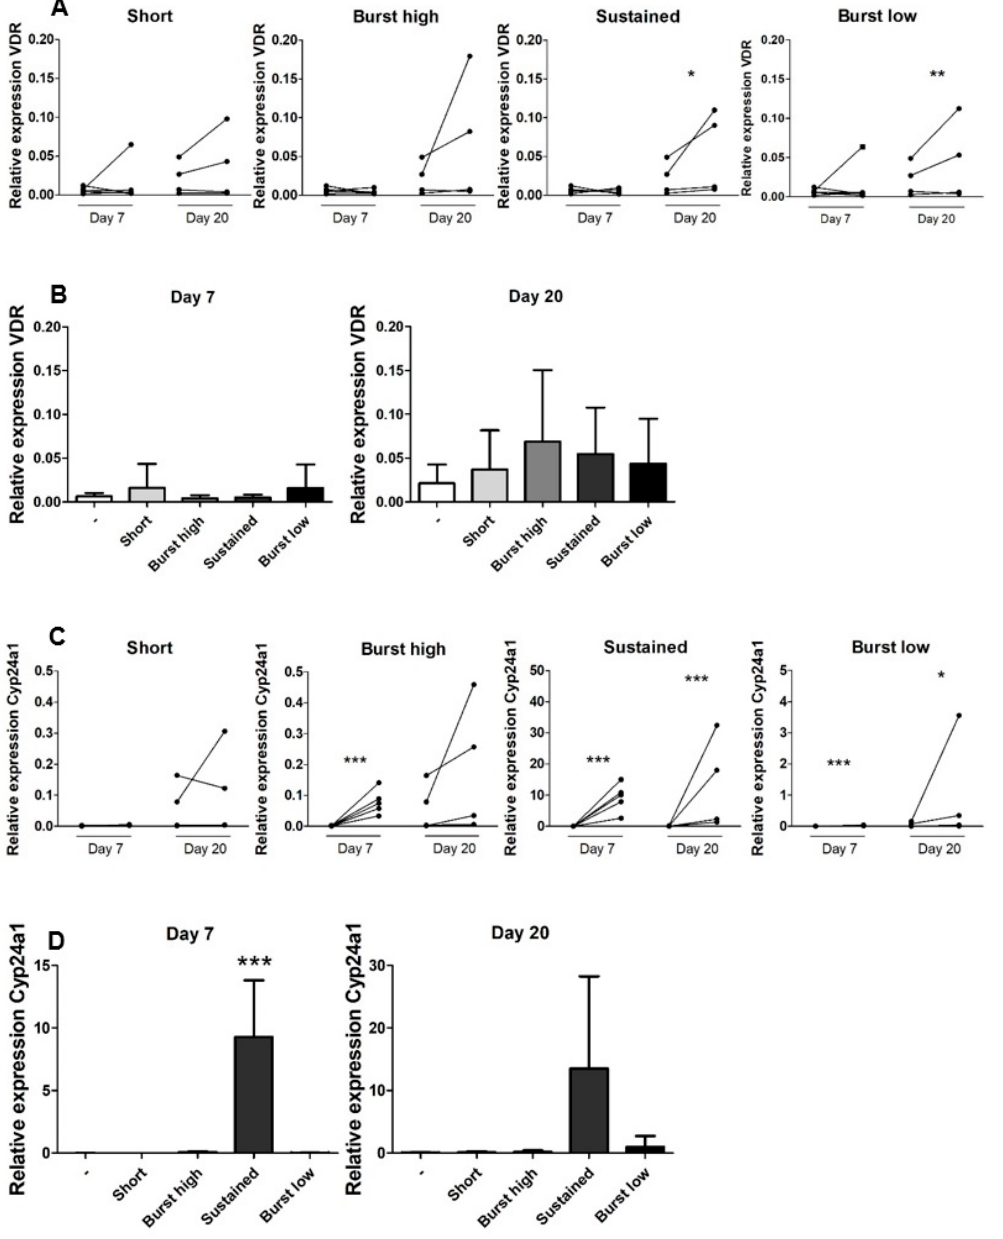
Figure 5. Gene expression of VDR and CYP24a1 . ( A ) VDR expression. Data of controls (left) and vitD 3 treated cells (right) from the same donor are connected with a line. ( B ) Average relative expression of VDR at Days 7 and 20. Data represent four or five independent donors (mean + SD). ( C ) Burst high, Sustained, and Burst low application of vitD 3 significantly increased CYP24a1 (note the 10-fold di ff erences in axis scale). Data of controls (left) and vitD 3 treated cells (right) from the same donor are connected with a line. ( D ) Average relative expression of CYP24a1 at Days 7 and 20. Data represent four or five independent donors (mean + SD). All gene expression data were normalized to HPRT . (A,C) * Significant di ff erence ( p < 0.05) between control and vitD 3 treatment at the same time point; *** p < 0.001. (D) * Significant di ff erence ( p < 0.001) between Sustained vitD 3 treatment and all other